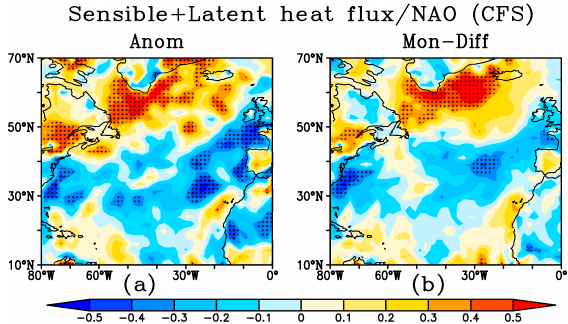
Figure 7. TCCs between the CFSv2-predicted NAO and the monthly ( a ) and monthly difference of ( b ) heat fluxes (sum of sensible and latent heat flux) in December at a 1- month lead. Dotted areas indicate statistical significance at the 95% confidence level, as estimated by a local Student’s t- test.